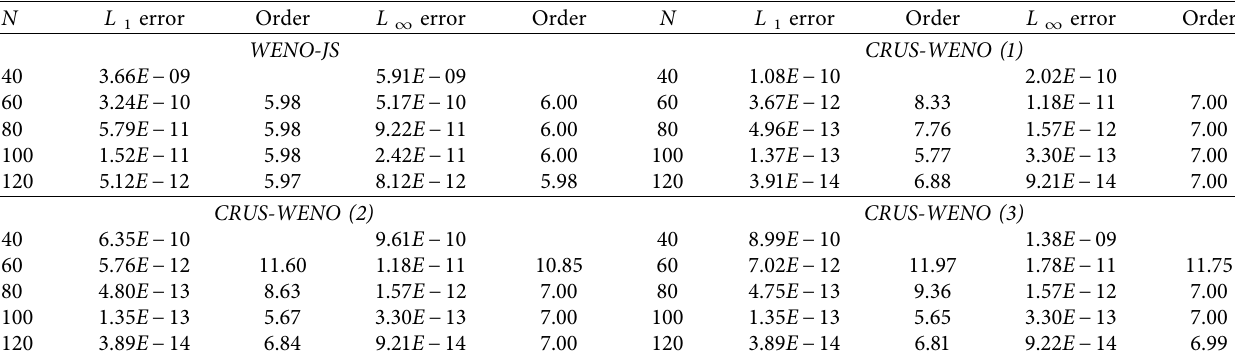
Table 1: Example 1. Heat equation. L